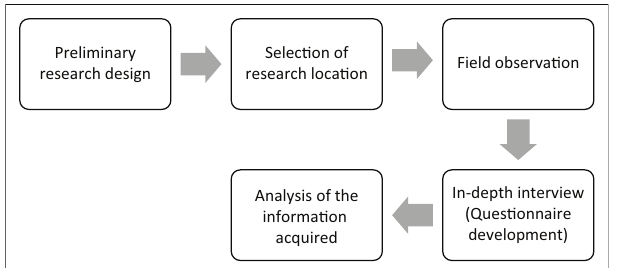
FIGURE 3: The method applied in this